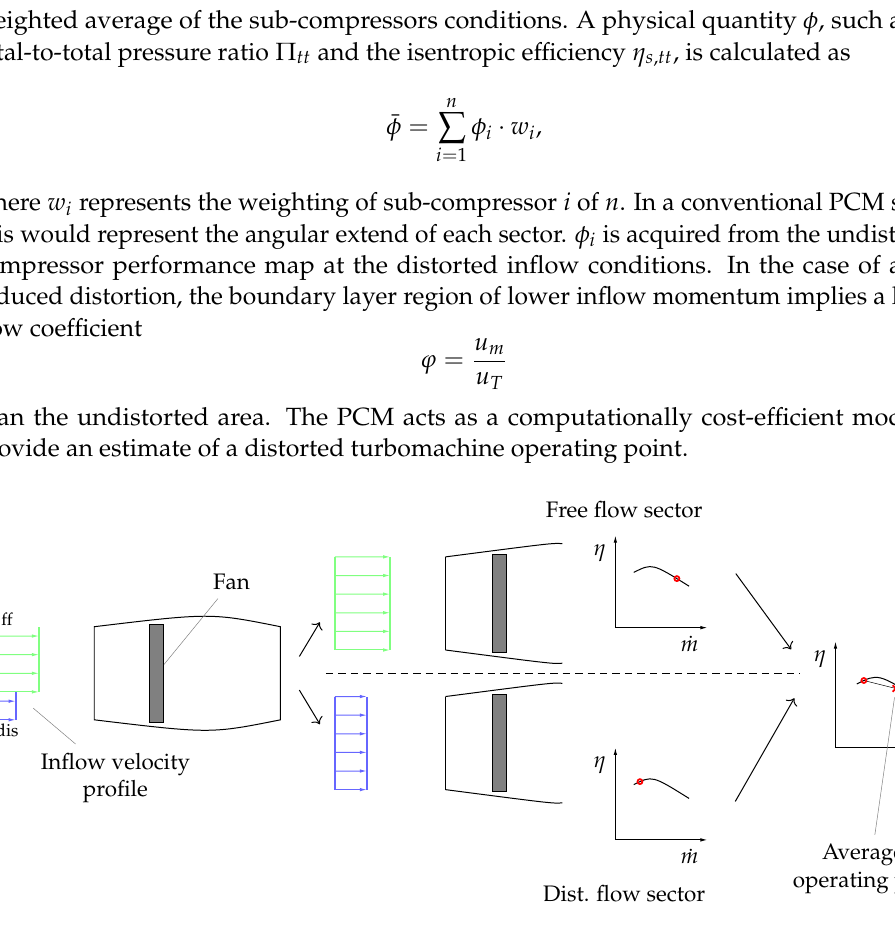
Figure 5. Inflow splitting and basic PCM Scheme (redrawn according to [12] Figure 3, under CC BY 4.0) (accessed on 25 April